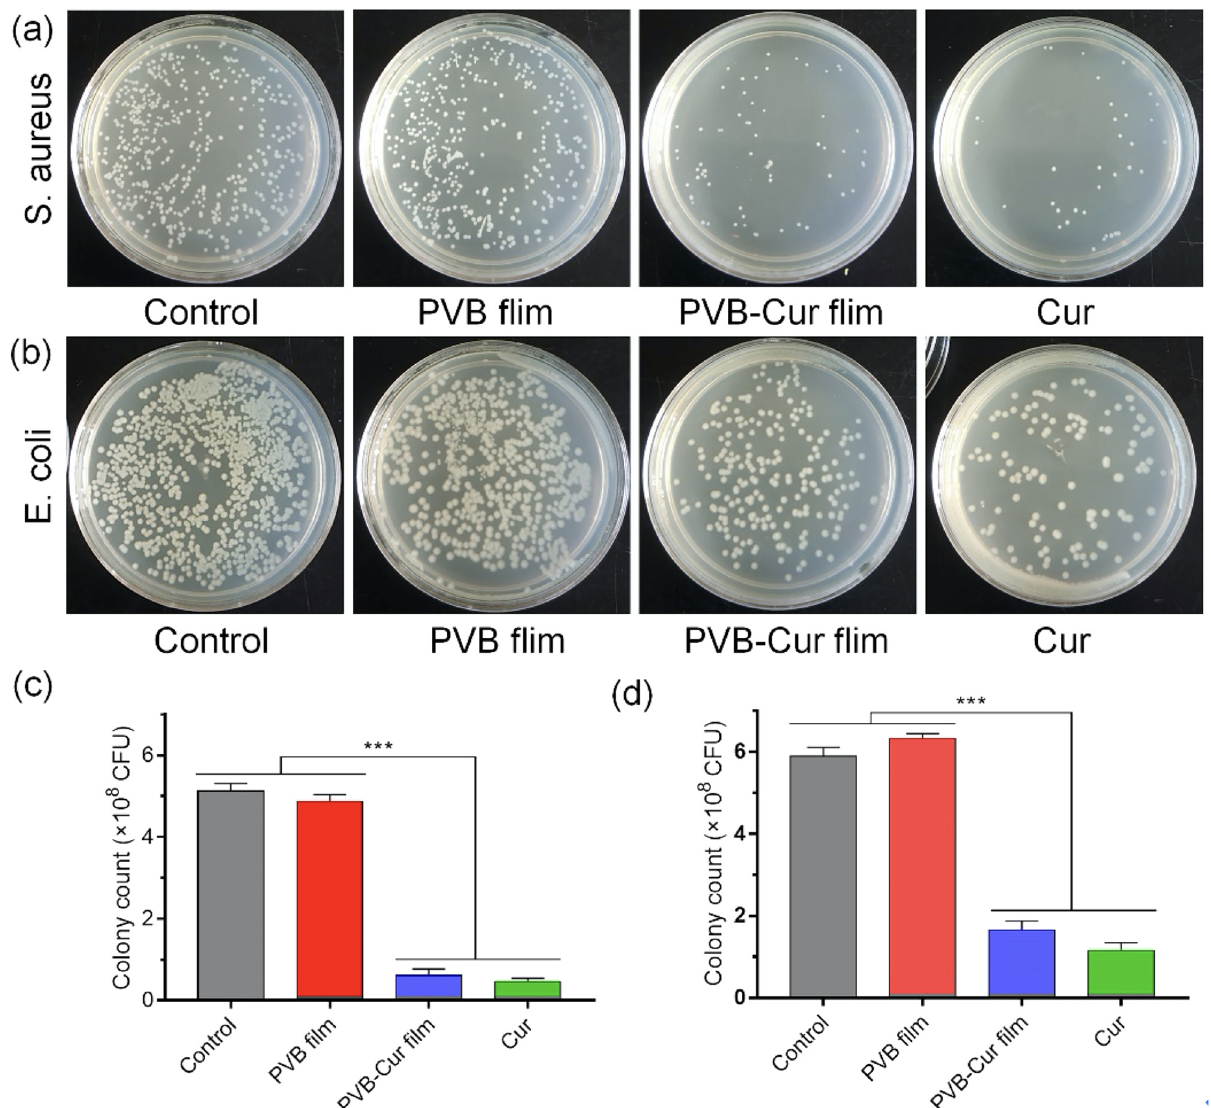
Figure 7: Antibacterial assays of S. aureus and E. coli . CFU photographs of S. aureus ( a ) and quantitative results ( c ) . CFU photographs of E. coli . ( b ) and quantitative results ( d )